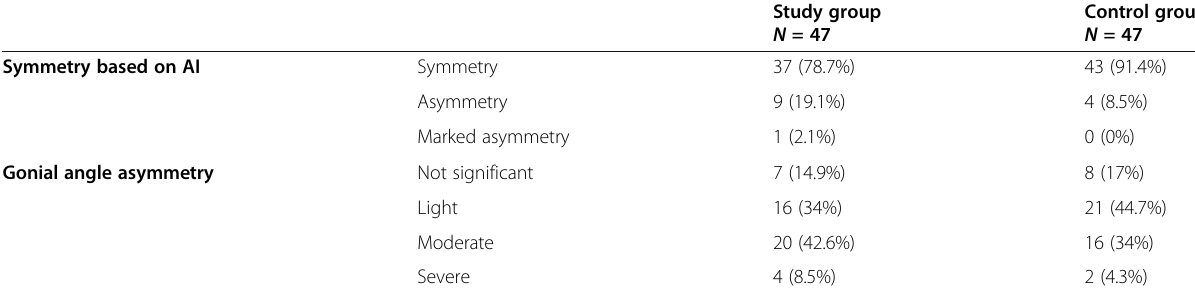
Table 3 Comparison between study and control groups based on AI (Asymmetry Index) and gonial